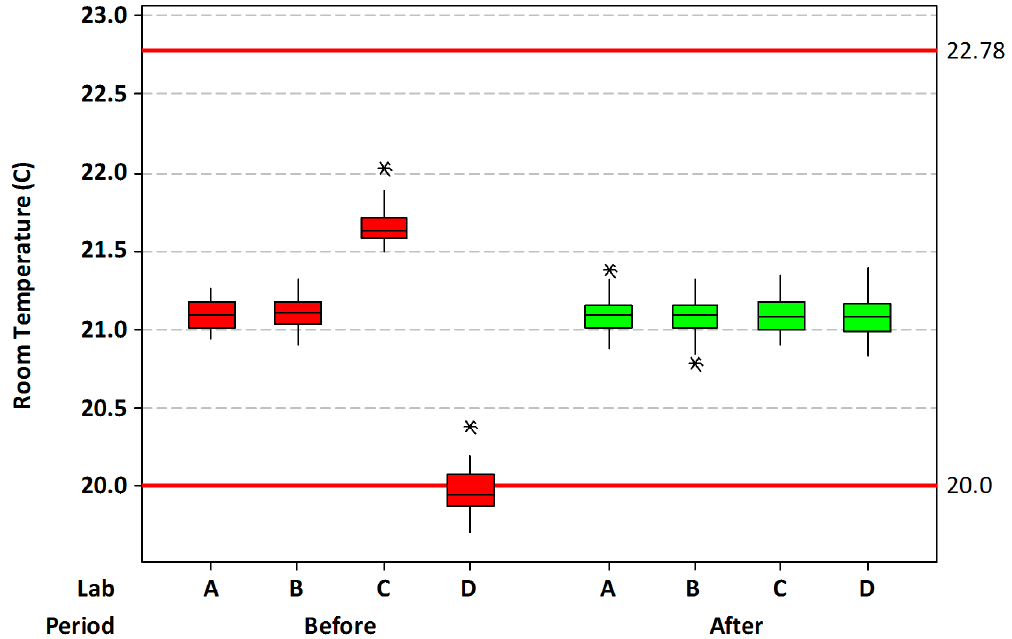
Figure 1. Ambient room temperature of the four rooms before and after temperature control adjustments. The control limits are those recommended by the Association of periOperative Registered Nurses (AORN). Asterisks (*) in the graph represent outlier points, i.e., at least 1.5 times the interquartile range; these points were not excluded from the analysis.